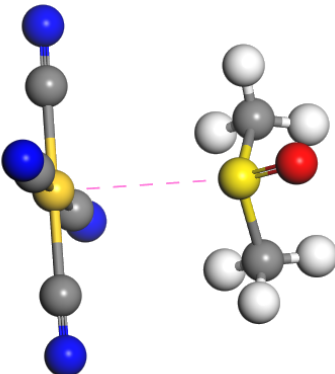
Table 5. Energy (E); energy corrected by the zero ‐ point vibrational energy (E + ZPVE); Gibbs free energy ( Δ G) of the complex formation of gold(III) tetracyanide dimethyl sulfide (1:2) complex. In vacuo—results obtained without solvation. DMSO—results obtained using PCM implicit solvation model. All values are in kcal/mol. Figure 4. The structure of the most stable gold(III) tetracyanide dimethyl sulfide complex isomer, [Au(CN) 4 DMSO] − κ‐ S. Atom coloring: Au—gold, C—grey, N—blue, S—yellow, O—red, and H—white. The pink dashed line represents the close contact between Au and S atoms. It should be noted that while extending the coordination number of Au(III) above four, the sulfur atom forms an energetically more favorable interaction with the central ion, instead of the oxygen. This is in opposition to the complex when the CN − ion was substituted by DMSO, as presented in Figure 3. Negative values of E and E + ZPVE indicate that intermolecular interactions between Au(CN) 4 − and DMSO can stabilize that kind of complex. The implicit solvent DMSO model results suggest that the κ‐ O and κ‐ S isomers are energetically similar; however, in vacuo calculations show the preference for κ‐ S isomer, which is opposite to the results obtained for Au(CN) 3 DMSO. Positive values of Δ G indicate that the complexes of Au(CN) 4 − and DMSO are thermodynamically not stable. Despite the intermolecular interactions occurring between the Au(CN) 4 − and DMSO, the decrease in entropy